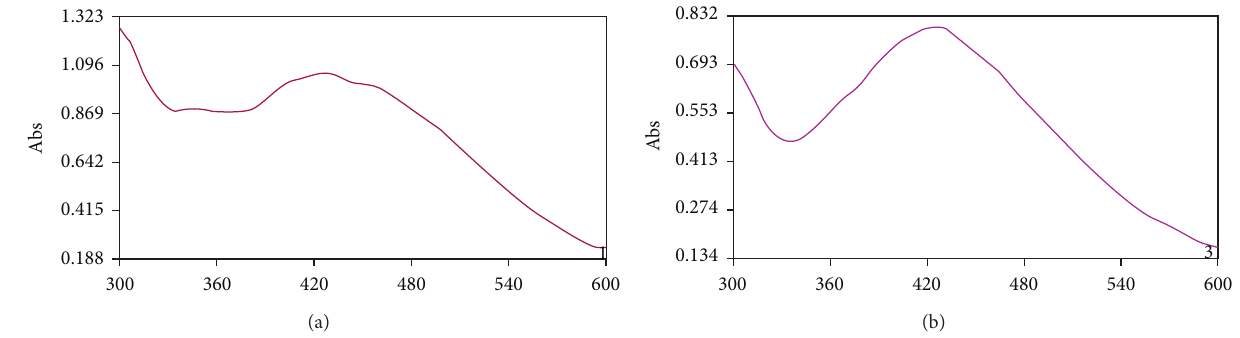
Figure 1: UV-visible absorption spectra of nanosilver synthesized using KFL (a) and KFS (b) extracts.